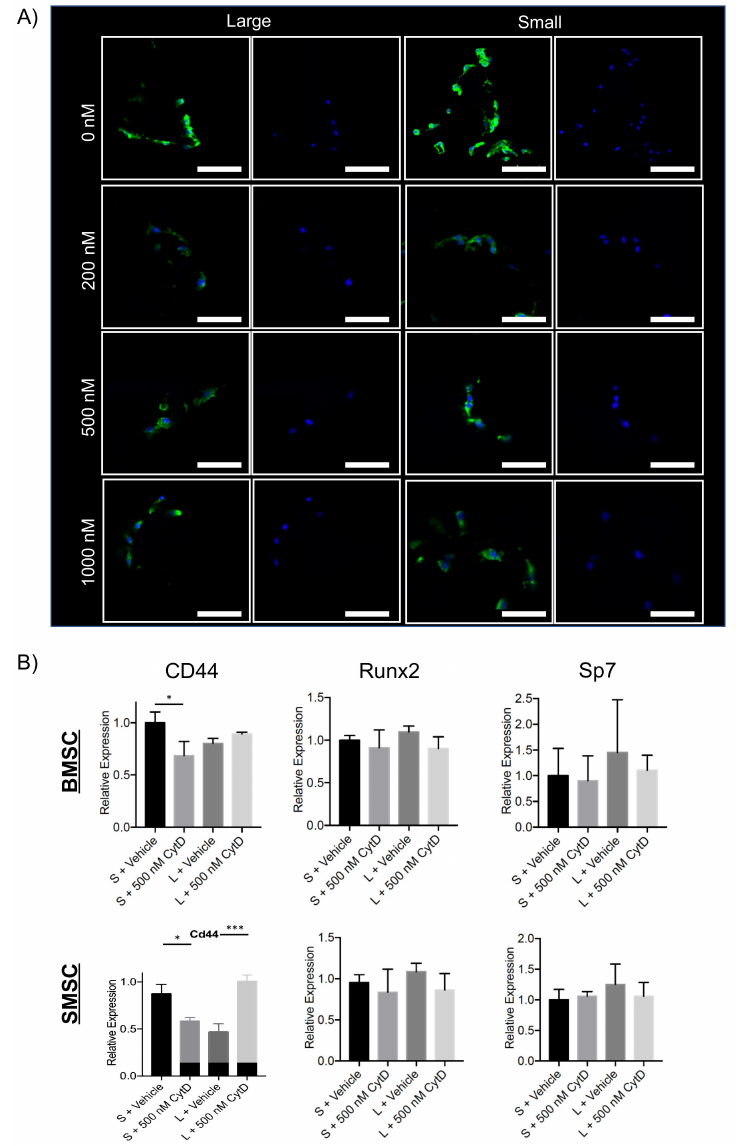
Figure 4. Confocal laser microscopy images of cells seeded to large ( left ) and small ( right ) pore scaffolds, cultured for 7 days in vitro and treated with Cytochalasin D (CytD) for 24 h (green: actin, blue: DAPI/nucleus; scale = 50 um, ( A )). Quantitative real-time polymerase chain reaction gene expression results for 500 nM CytD treatment compared to vehicle control are shown below ( B ). * = p < 0.05, *** = p <